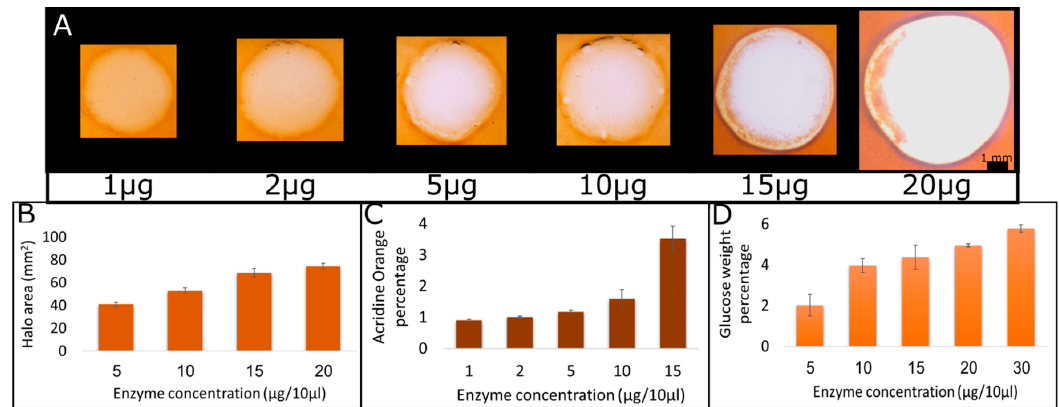
Figure 2. Halo size, dye, and hydrolysis products correlation with enzyme concentration. Halo size was visualized ( A ) and measured ( B ) on films subjected to different enzyme concentrations. Film wash water was analyzed using UV-vis spectroscopy ( C ) and Sumner’s method followed by UV-vis spectroscopy ( D ). CMC dyed films were subjected to 10 μ L of different amounts of cellulase. The films were incubated at 37 °C for 2 h and washed with 10 mL water. The halo was visualized ( A ), measured ( B ), and wash water was analyzed using UV-vis spectroscopy. The absorbance at 480 nm was used to calculate acridine orange concentration based on a calibration curve, and the percentage of dye released by hydrolysis is shown ( C ). Additionally, CMC films with no dye were subjected to different amounts of cellulase for 16 h at 37 °C. Wash water was subjected to Sumner’s method. Absorbance was measured using UV-vis. Absorbance at the peak was used to calculate reducing sugars concentration based on a calibration curve and their weight percentage from the CMC film is shown ( D ). The assay was repeated 3 times.